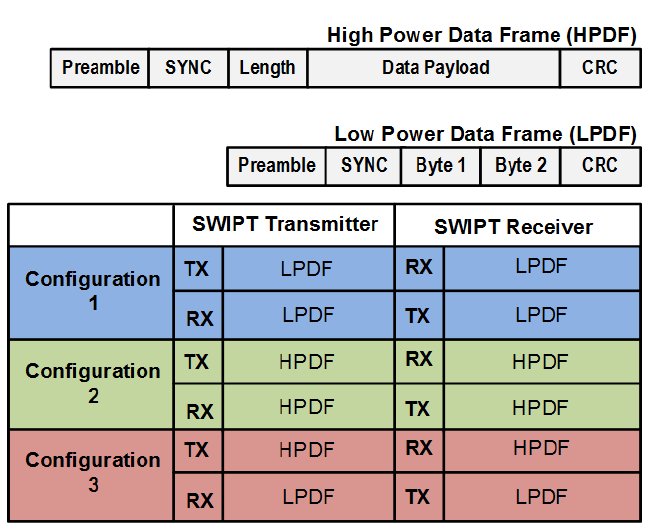
Figure 4. Top operation of the ACCP in SWIPT system.